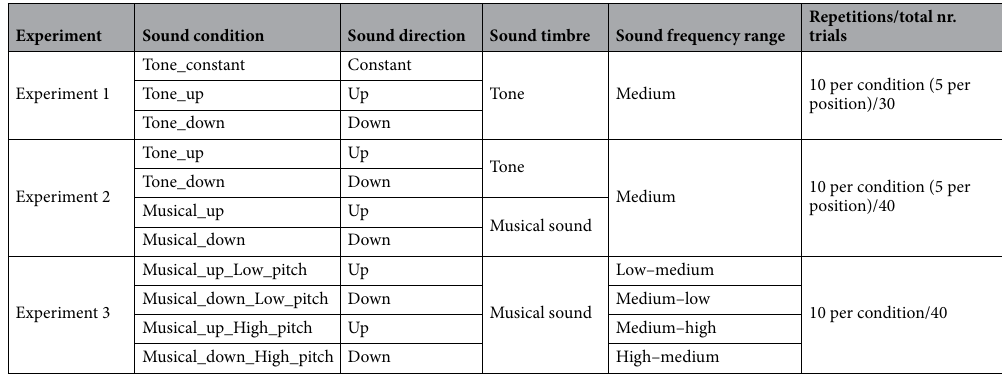
Table 2. Summary of the experimental conditions (ordered randomly), factors and number of repetitions and trials in Experiments 1, 2 and